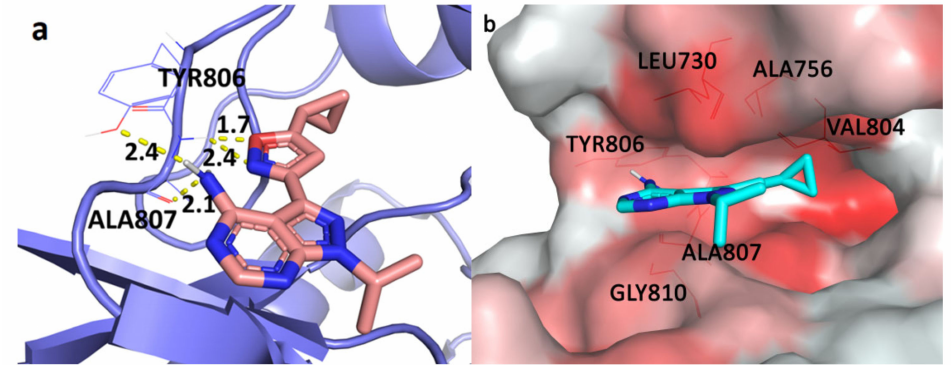
Figure 1. ( a ) Docked conformation of the most active compound 25 (shown in stick model) inside the active site of rearranged during transfection (RET) kinase. Hydrogen bonds are represented as yellow dotted lines and their distances are labeled in angstrom. ( b ) The most active compound 25 (shown in stick model) inside the hydrophobic pocket of RET; the red colored region represents the most hydrophobic surface and white color represents the least hydrophobic surface of the protein. Hydrophobic residues are shown in the red colored line